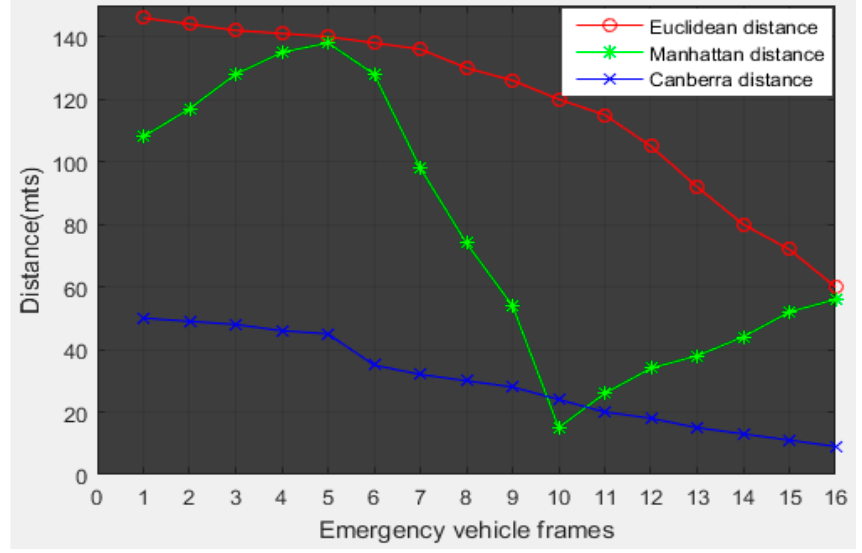
Figure 16. Comparison between the distance measurement techniques.